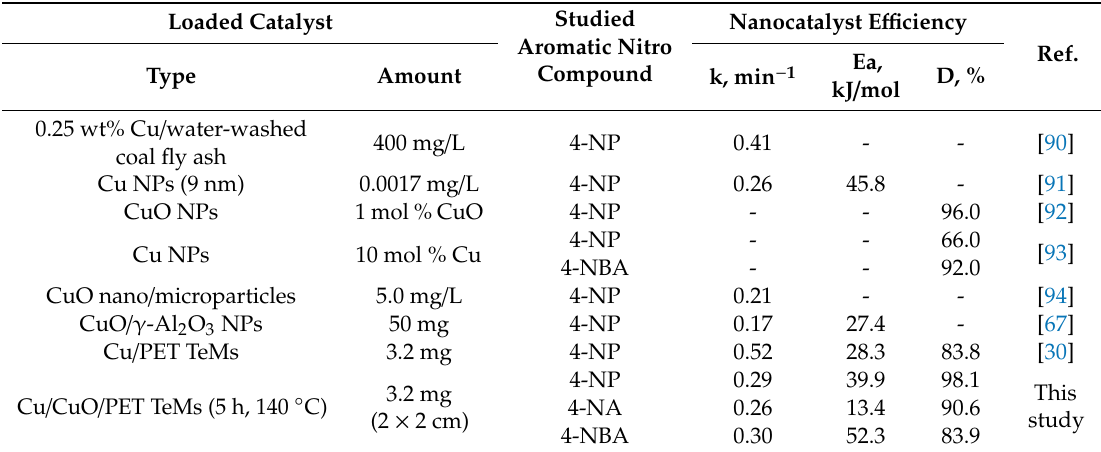
Table 3. Catalytic activity of the copper and copper(II) oxide nanostructures as well as TeMs-supported catalysts in the hydrogenation reaction of aromatic nitro compounds.